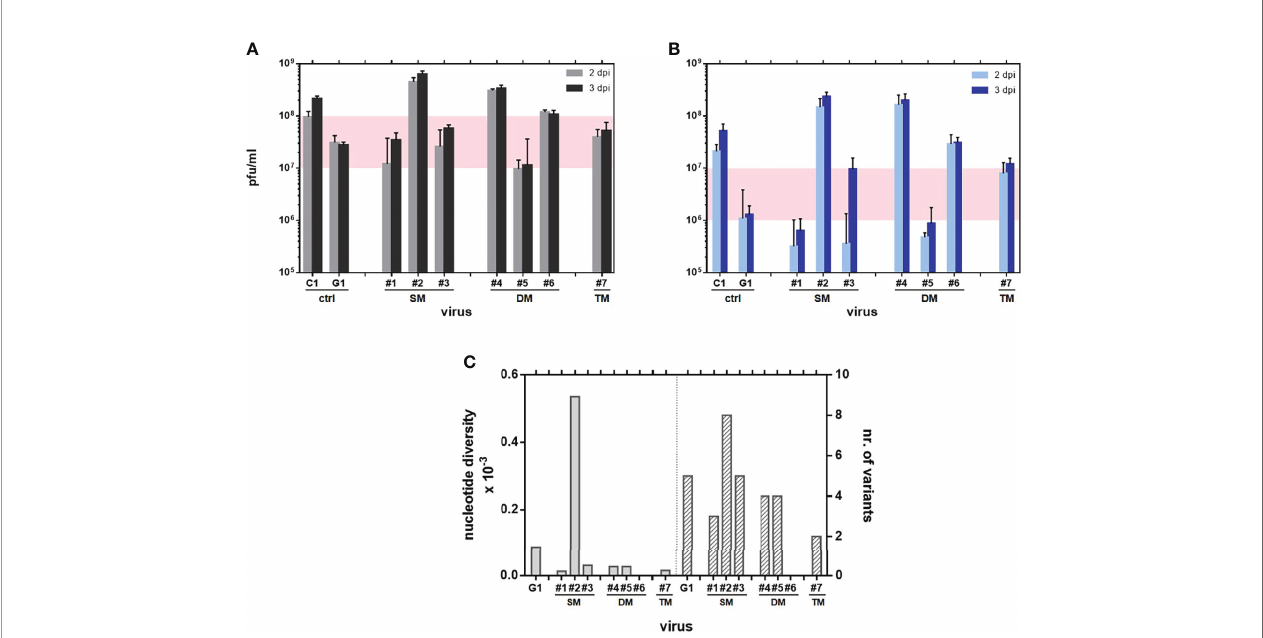
FIGURE 1 | Kinetics of growth in mammalian cells: Vero (A) and HEK293T (B) cells were infected at a MOI of 0.01 with the indicated rRVF viruses ( Table 1 ). Supernatants collected at 48 and 72 hpi were titrated onto Vero cells by a plaque assay. Experiments were performed in duplicate. Data shown correspond to a single representative assay. The range of fi nal yield between both wild-type polymerase-control viruses C1 and G1 has been shaded. (C) Nucleotide diversity bars per sequenced sample (left) and total number of variants annotated per sample (right). No data could be retrieved for